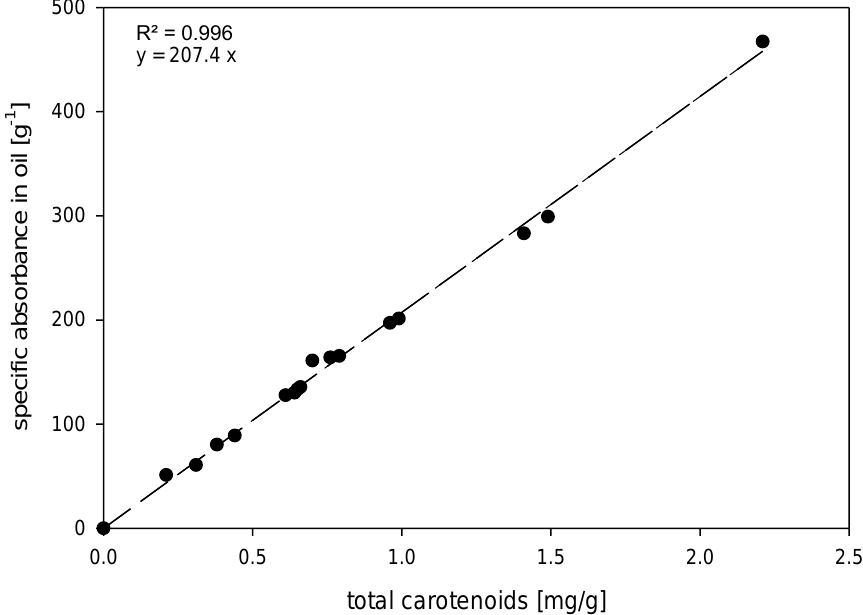
Figure A1. Correlation between the specific absorbance of carrot concentrate powders after extraction in sunflower oil and total carotenoids determined by solvent extraction in hexane. Sample points represent the mean of a triplicate analysis.